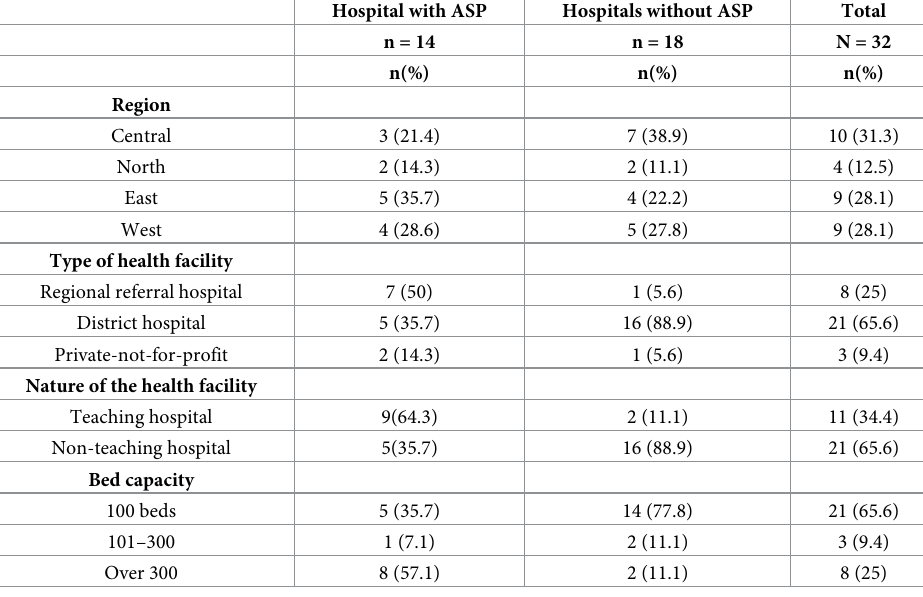
Abbreviations, ASP: Antimicrobial Stewardship programmes, %: